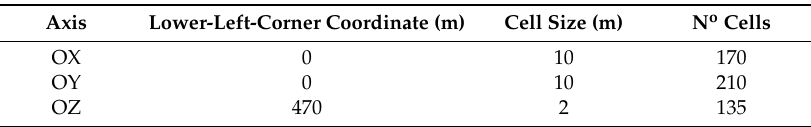
Table 1. Stope grid (10 m × 10 m × 2 m) settings.